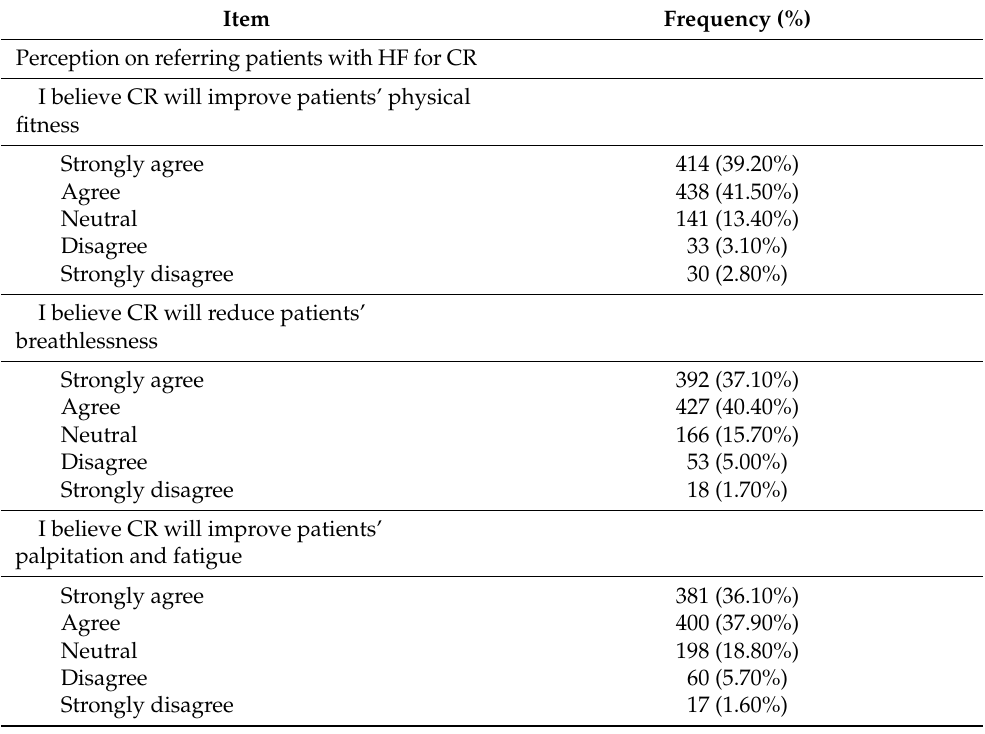
Table 2. Perception on referring patients with heart failure for cardiopulmonary rehabilitation ( n = 1056).